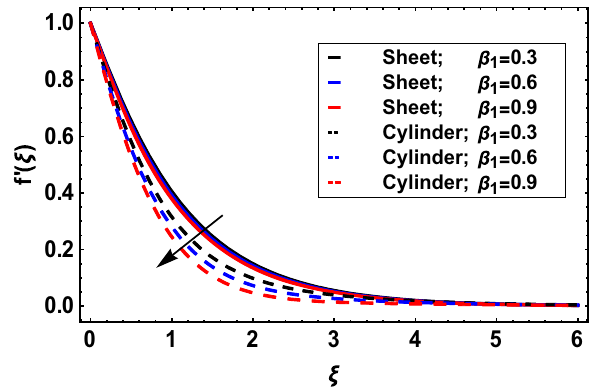
Figure 5: Change in nano fl uid velocity due to β